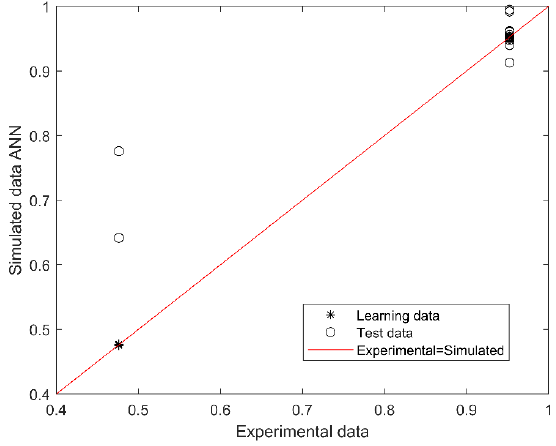
Figure 1. Scatter plot of experimental (actual) and simulated (predicted) data for SGA or AGA. The outcome (output of the model) is SGA or AGA (codified as 0.5 or 1.0). The red line indicates the linear regression model on scatter points, and the output is the best linear fit obtained by the ANN model. The range between 0.4 and 0.79 corresponds to SGA and between 0.8 and 1.0 to AGA prediction.